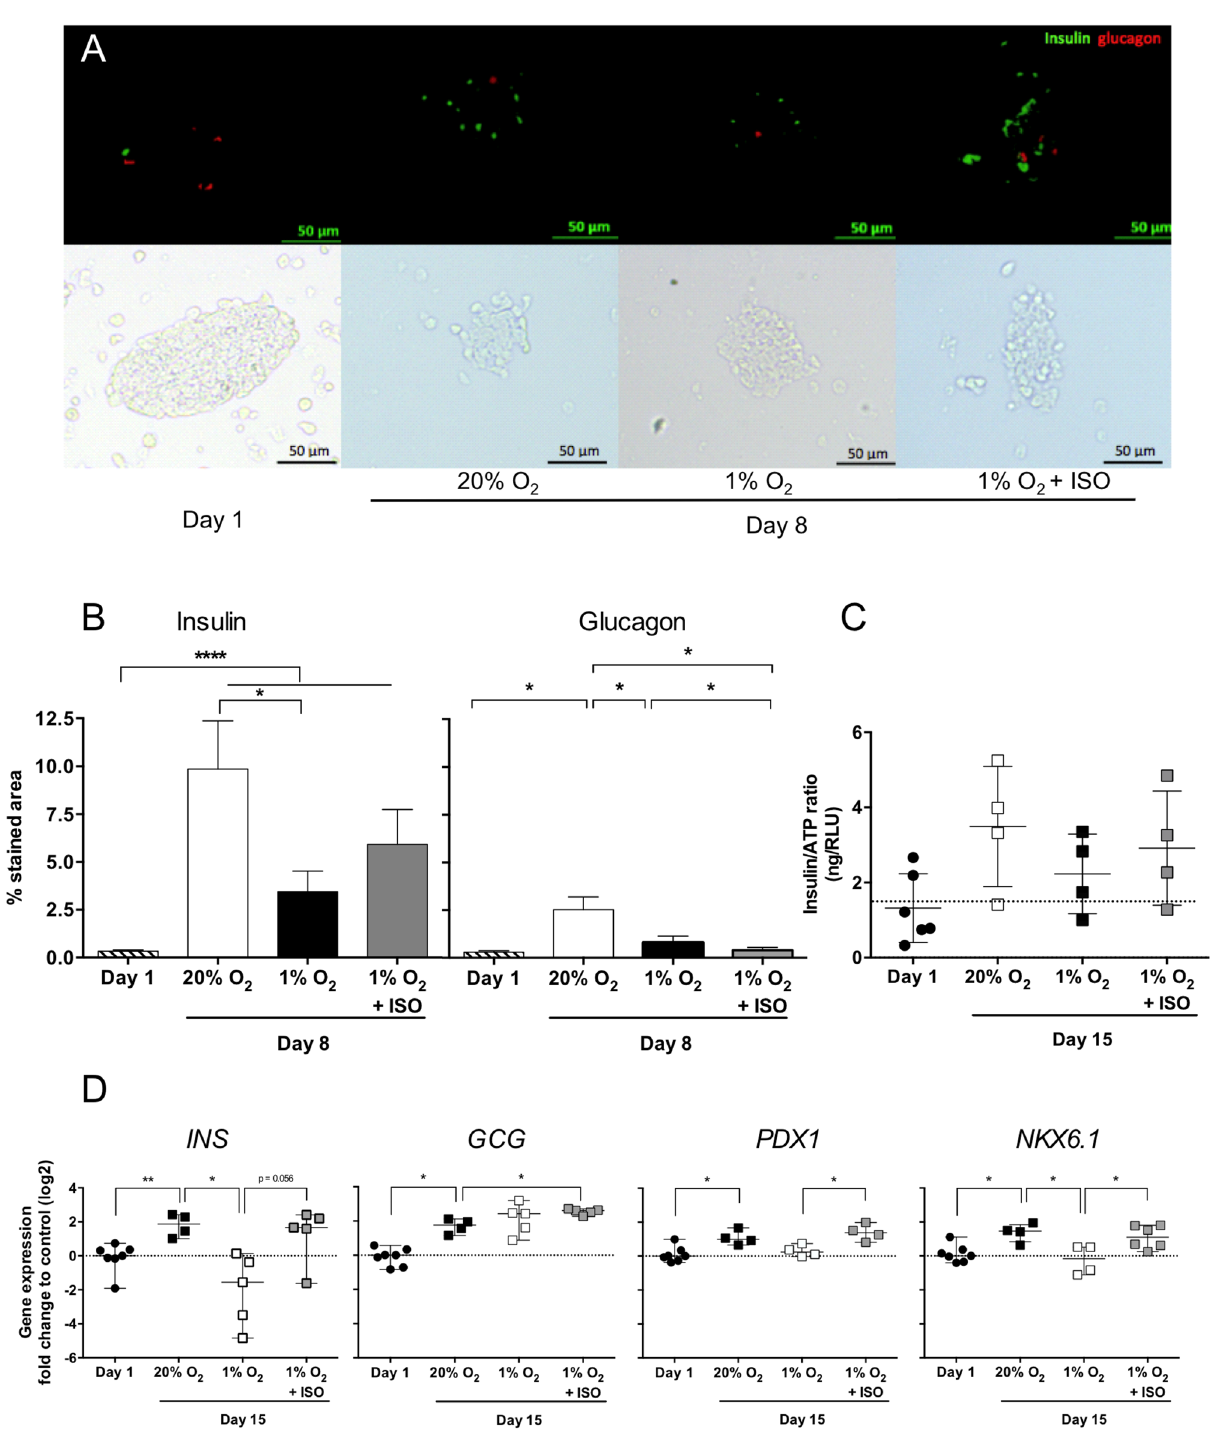
Figure 6. Effect of O 2 strategy on the maturation of neonate pig islets (NPIs) embarked in O 2 balanced BAPs. The analyses were performed on pre-encapsulated NPIs 24 h after isolation (day 1) and on encapsulated NPIs cultured for 8 or 15 days within BAPs in 20% O 2 (positive control) and 1% O 2 conditions without the O 2 strategy (1% O 2 , negative control) or with the O 2 strategy composed of silicone-CaO 2 disk and 500 µg/mL HEMOXCell by alginate (1% O 2 + ISO) (n = 4–7 pigs). ( A ) Immunostaining of insulin ß cells (green, Alexa-Fluor 488) and glucagon α cells (red, Alexa-Fluor 555) staining of NPIs in 4 µm thick cross-sections. Views in white light are shown to the lower-left of each photo. The scale is indicated in each picture. ( B ) Percentage of mean insulin-positive area per islet (Insulin) and percentage of mean glucagon-positive area per islet (Glucagon). The percentages of insulin and glucagon were quantified within 150 islets in day 1 (n = 4 pigs) and an average of 30 islets per condition after day 8 of culture (n = 3 pigs). ( C ) Intracellular insulin by ATP content ratio. ( D ) Relative quantitative RT-PCR expression analysis of insulin ( INS ), glucagon ( GCG ), pancreatic progenitor transcription factor ( PDX1 ) and NKX6.1 ( NKX6.1 ). *p < 0.05, ****p < 0.0005 (Unpaired parametric t-test or Mann–Whitney